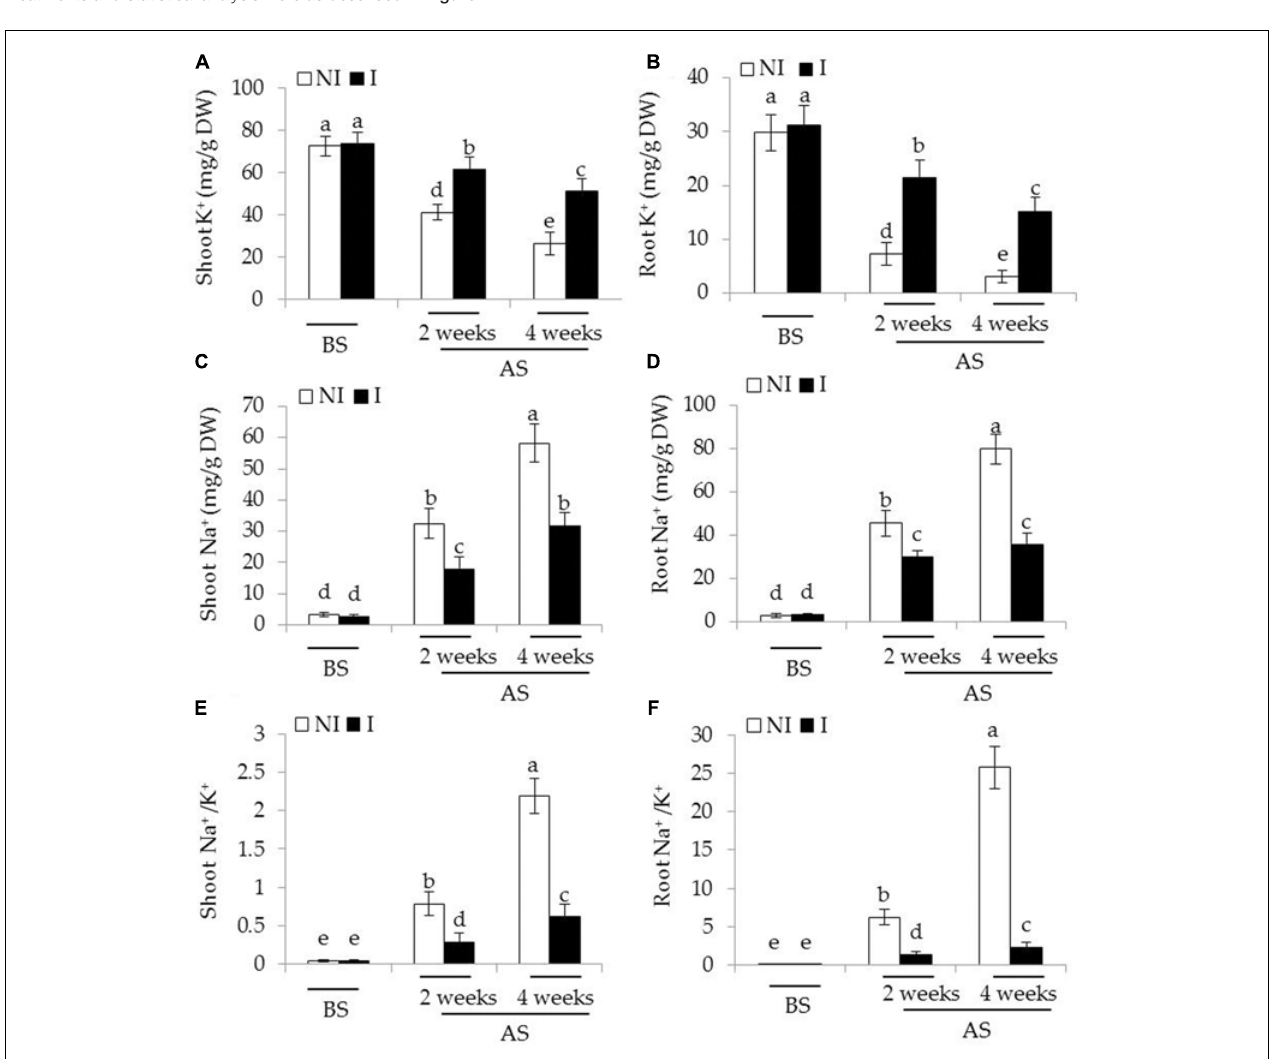
FIGURE 3 | Effects of B. licheniformis SA03 on (A,B) K + concentration, (C,D) Na + concentration, and (E,F) Na + /K + ratio of shoots and roots in Chrysanthemum plants before (BS) or after (AS) saline–alkaline treatments. Treatments and statistical analysis were as described in Figure 2